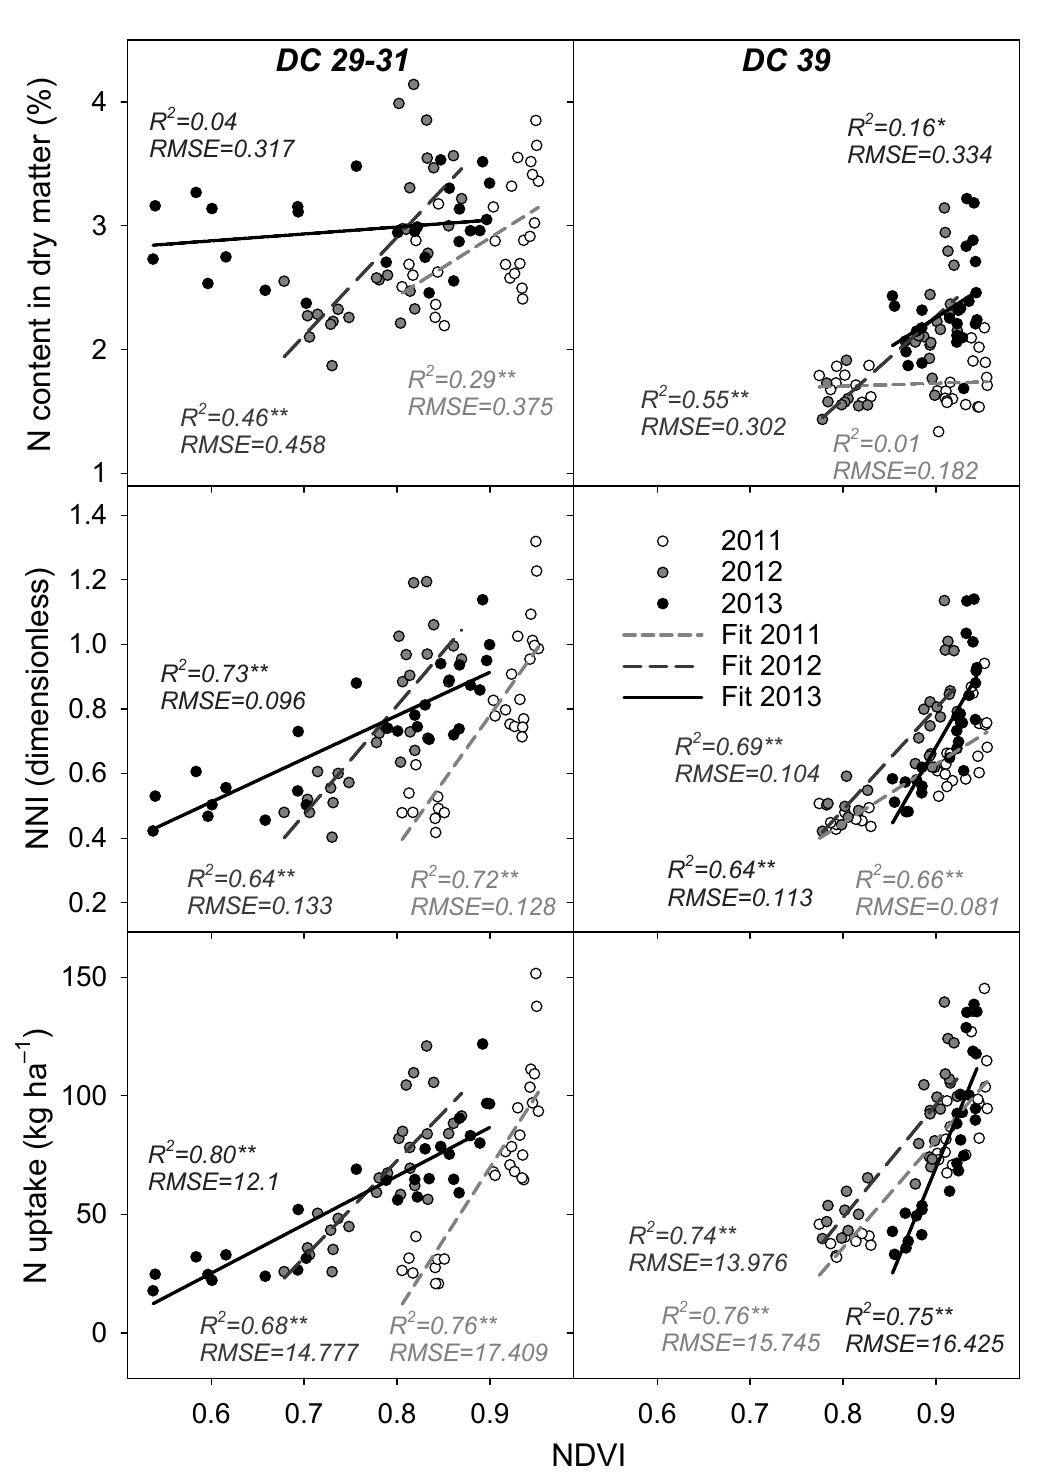
Figure 2. Linear relationships between vegetation index NDVI and nitrogen content in aboveground dry mass ( upper ), nitrogen nutrition index (NNI, middle ), and nitrogen uptake by aboveground biomass per area unit ( lower ), analyzed separately for growth stage beginning of stem elongation (DC 29–31, left ) and end of stem elongation (DC 39, right ), and for individual years (2011—white points and light grey line, 2012—grey points and dark grey line, and 2013—black points and black line). Coefficients of determination ( R 2 ), root mean square errors (RMSE), and significant correlations (* at p < 0.05 and ** at p < 0.01) are indicated for each relationship.